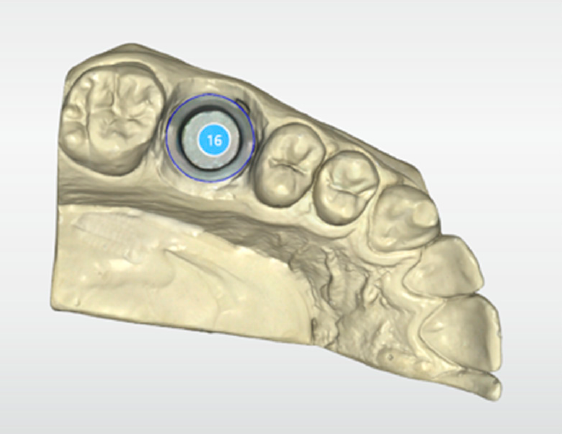
Figure 2. Occlusal view of the 3D model obtained with Cerec Primescan. 16: first uppor right molar.